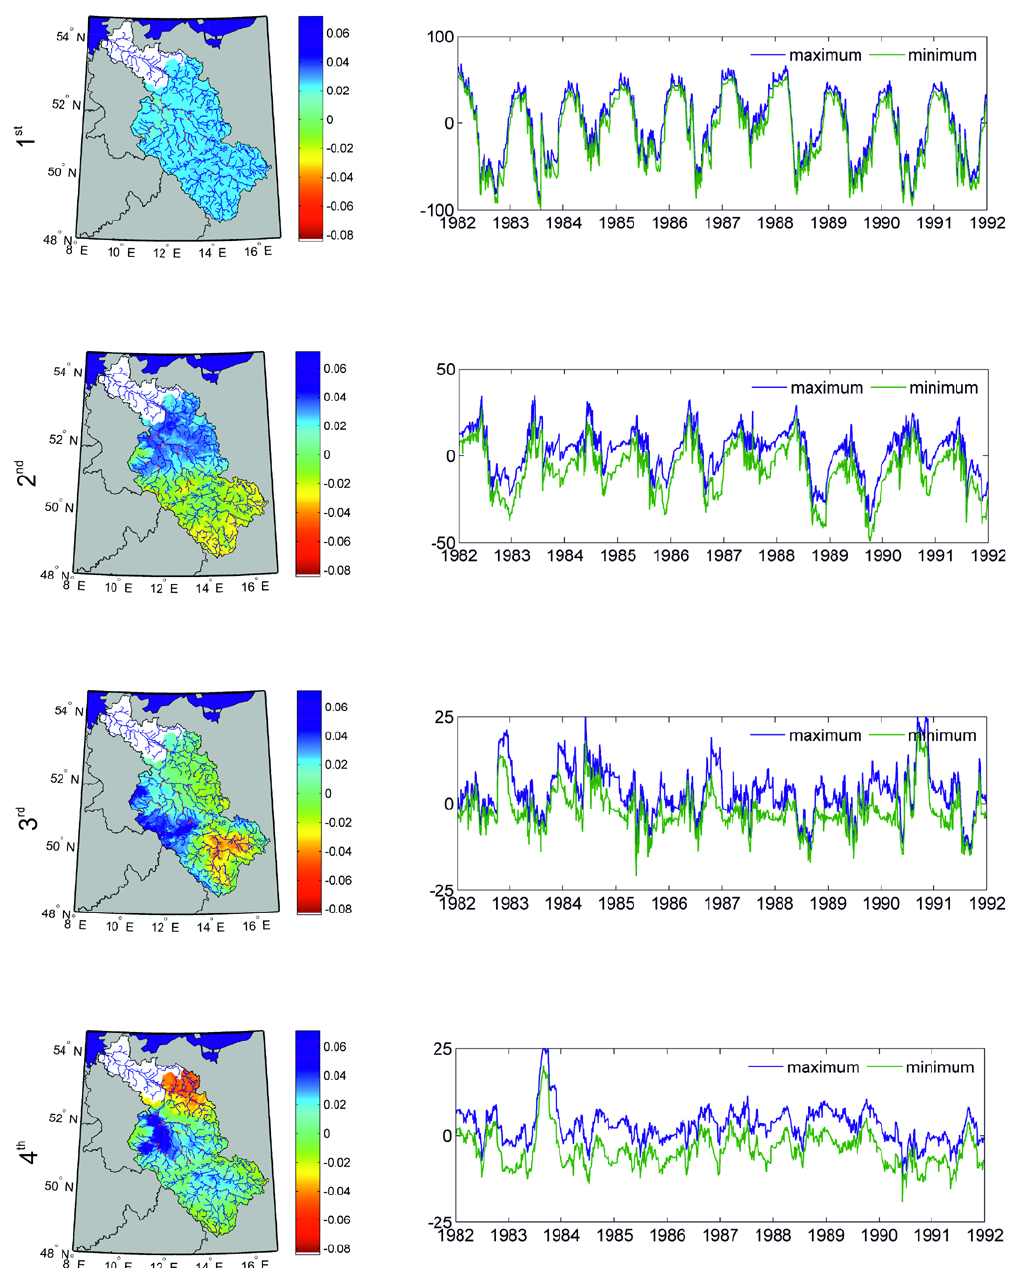
Fig. 4. Eigenvectors (left) and their corresponding PCs (right) of the leading four PCs. PCs are displayed for the sub-period 1982–1991. Minimum and maximum values correspond to the parameter uncertainty introduced by the rainfall-runoff